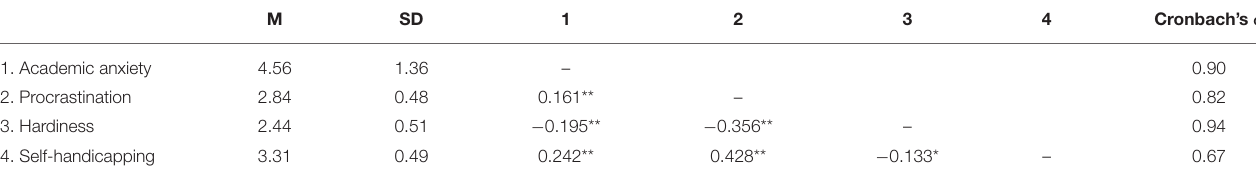
TABLE 1 | Descriptive statistics and inter-correlations between variables.